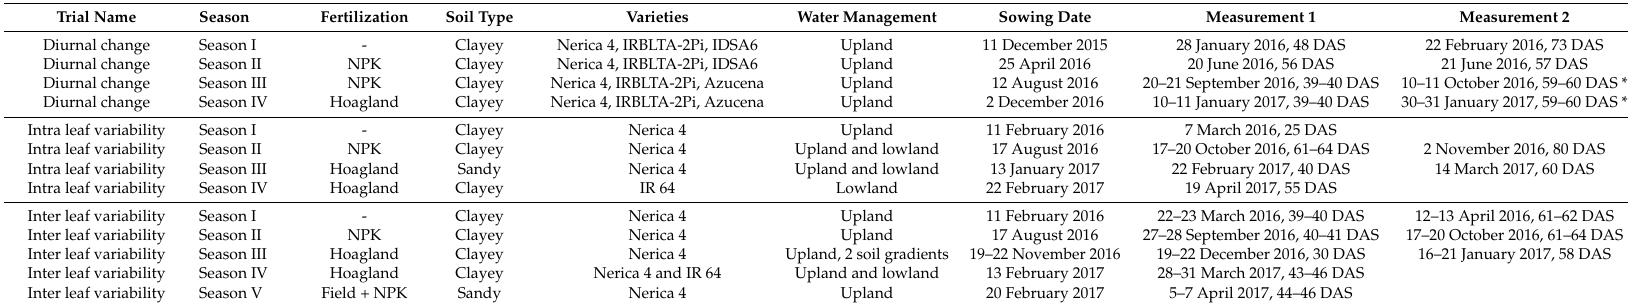
* Measurements interrupted by heavy rains/stormy weather on 10 October 2016 and 31 January 2017 have not been used in the analysis. DAS, for days after sowing are